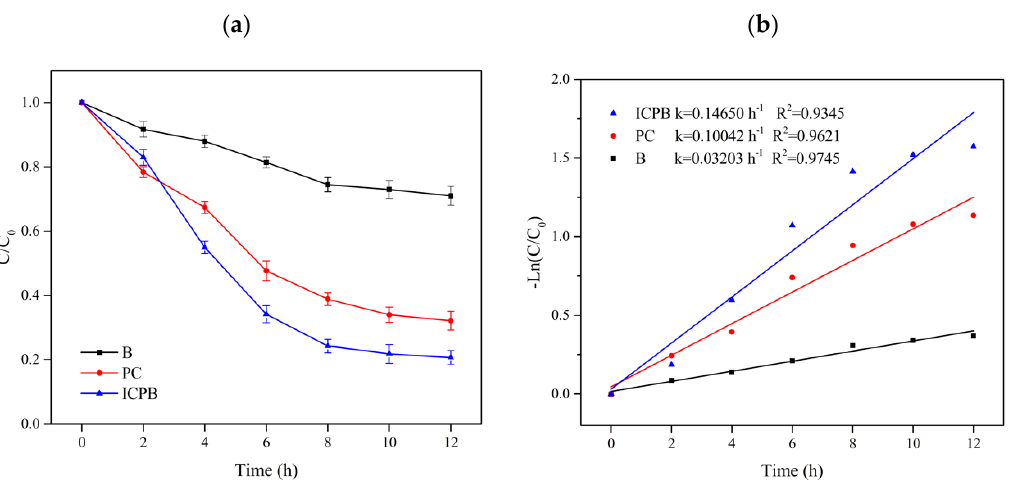
Figure 5. Curves of TOC degradation ( a ) and kinetics ( b ) in B, PC, and ICPB. B—biodegradation without light; PC—photocatalysis without microorganism; ICPB—intimate coupling of biodegradation and photocatalysis.